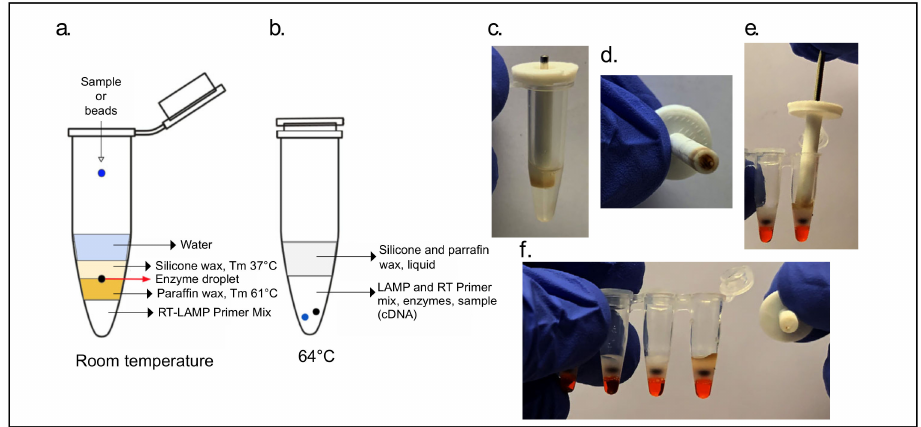
Figure 2. Easy to use Accessible LAMP-Enabled Rapid Test (ALERT) cartridges. One-step reaction- ready cartridge layering: cartridge layers at ( a ) room temperature and ( b ) at 64 ◦ C. Demonstration of magnetic wand; ( c , d ) wand accumulates beads and ( e ) is placed into the reaction cartridge where ( f ) the magnet is removed to release beads, reagents have dyes added for demonstration